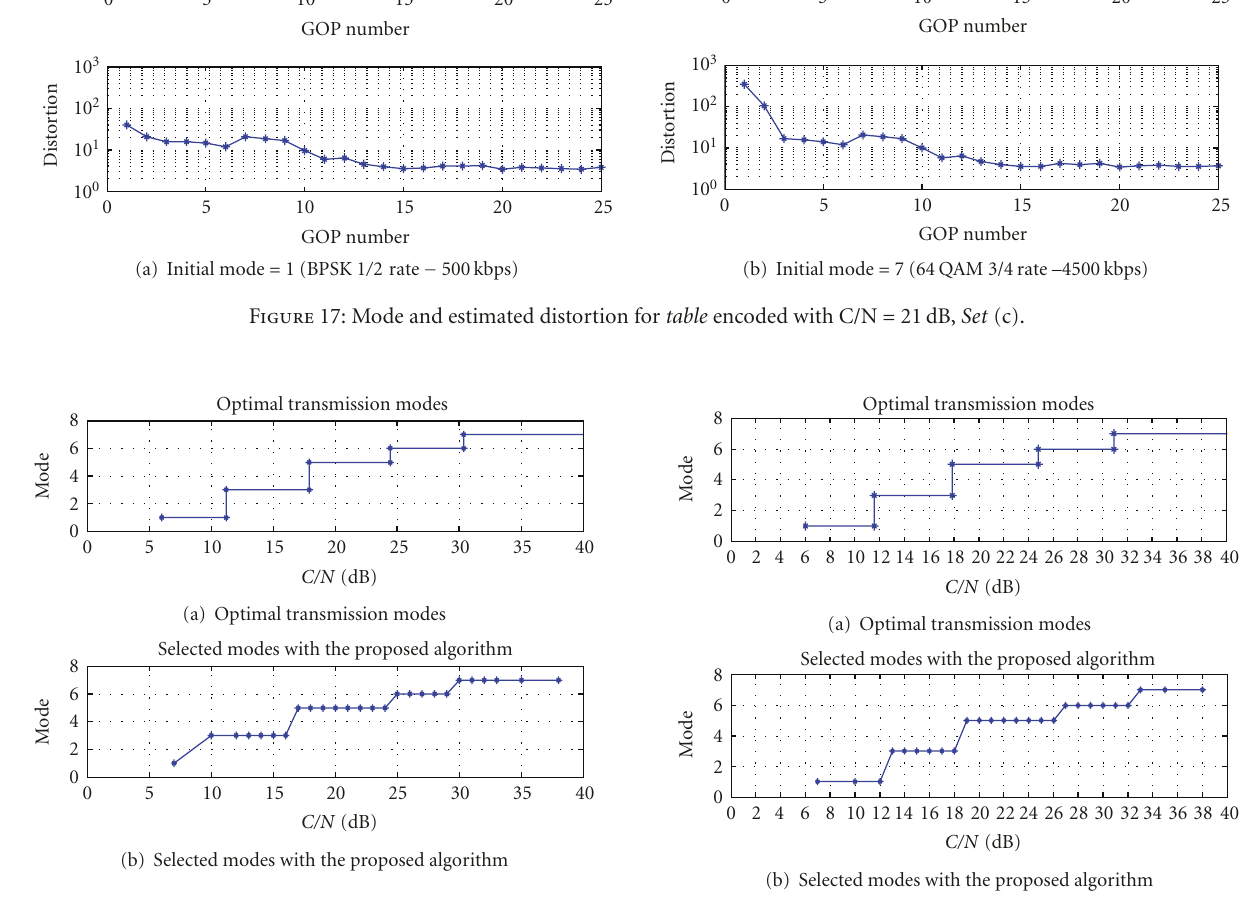
Figure 18: Mode selection comparison, table , GOP number 15, initial mode = 3, Set (a).